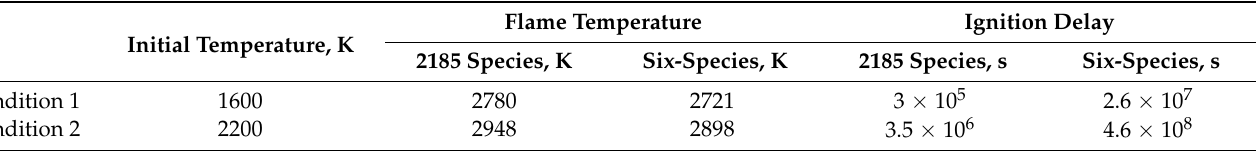
Table 1. Comparison of adiabatic flame temperature and ignition delay with